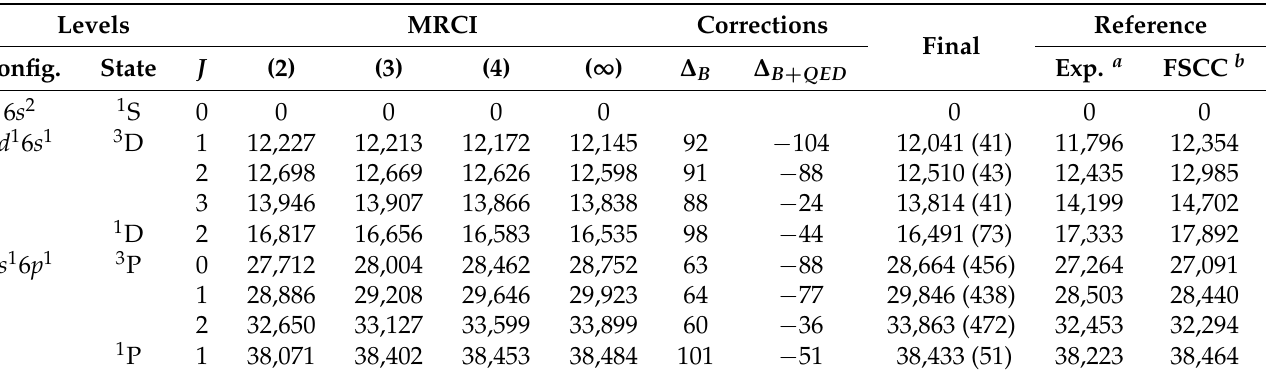
a Taken from [21,22]. b Taken from [23].